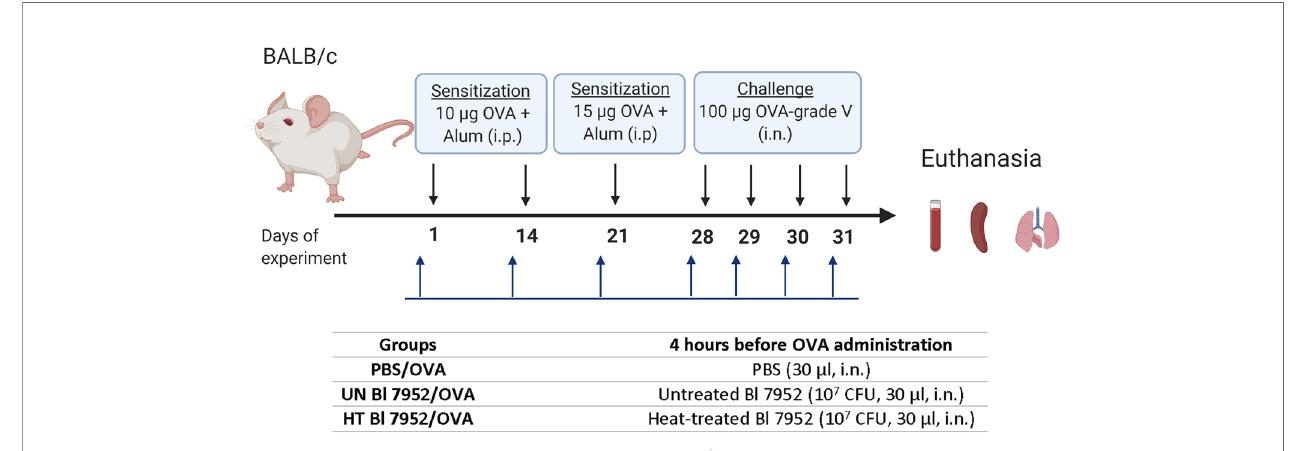
FIGURE 1 | Experimental design — bacterial administration and systemic sensitization and challenge of BALB/c mice to OVA. Female BALB/c mice 6 – 8-week-old (n = 6 to 8) were i.p. sensitized with 10 µg of OVA + Alum on days 1 and 14 of experiment, boosting dose of 15 µg of OVA + Alum was administrated on day 21. Seven days after third immunization, the challenge with 100 µg of OVA was performed for 4 consecutive days. Untreated (UN Bl 7952) or heat-treated (HT Bl 7952) bi fi dobacteria in dose 1 × 10 7 CFU/30 µl or PBS were administered intranasally 4 h before each sensitization and challenge. Mice were euthanized on day 32, and samples were collected (Created with